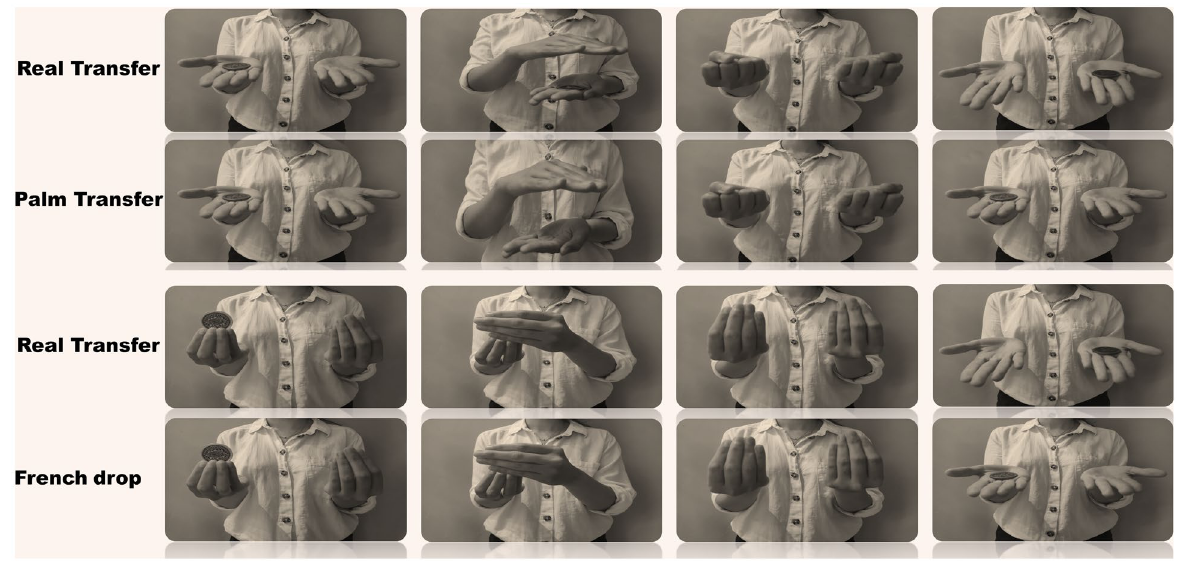
Figure 1. Hand movements of the magic effects (Palm transfer and French drop) and corresponding real transfer